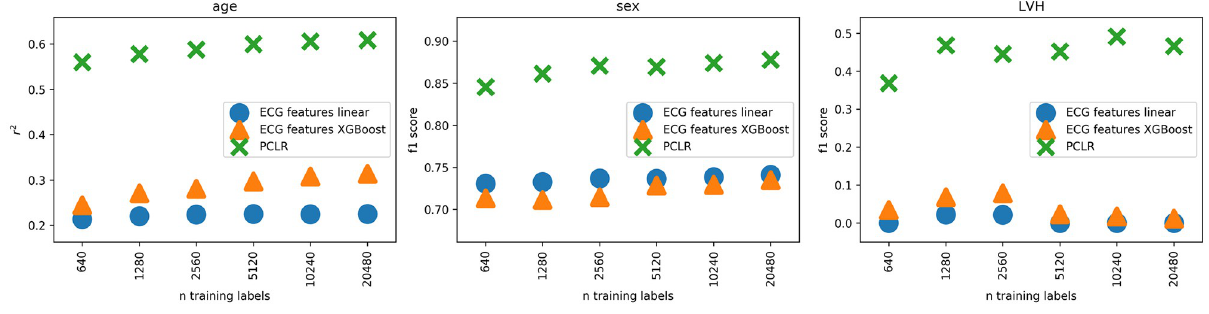
Fig 8. Comparison against standard ECG